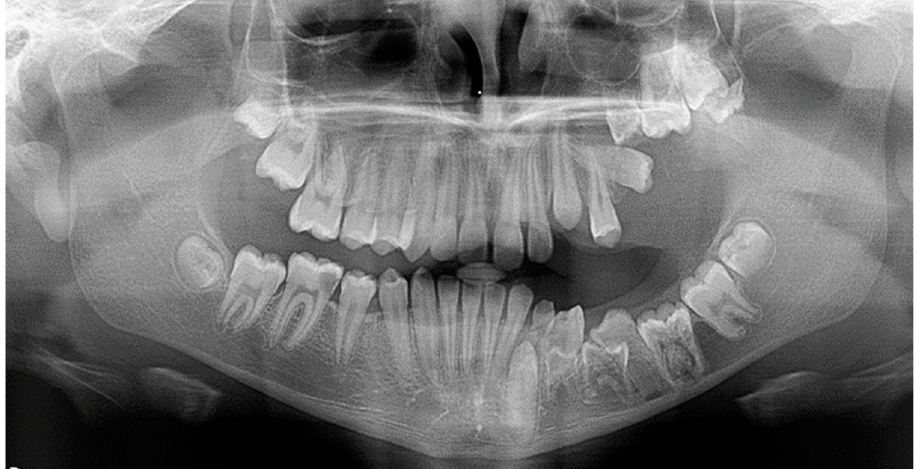
Figure 1. Primary failure of eruption of upper and lower molars.